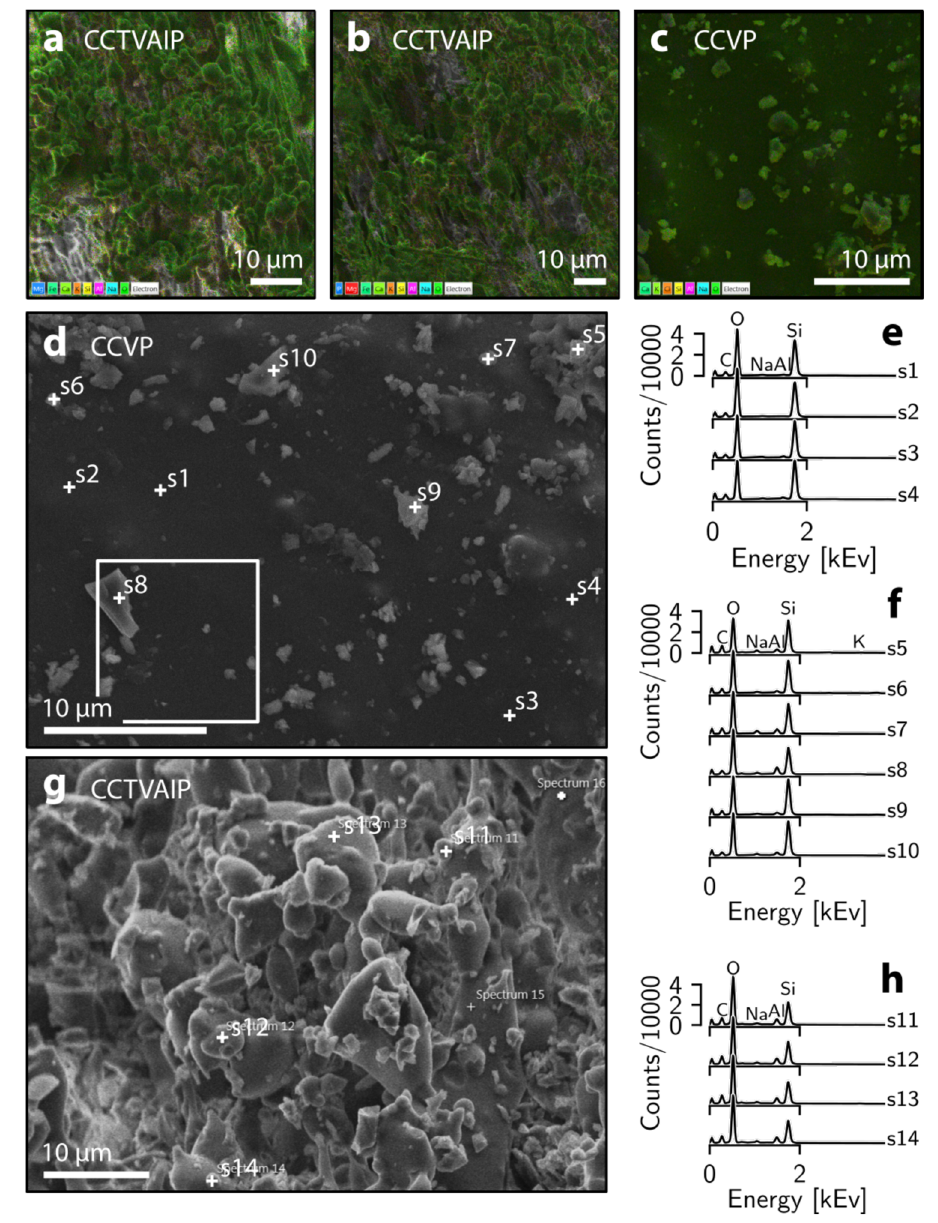
points s5 – s10 (discrete particles) in f . Peaks for C, O, Na, Al, Si, and K are high- lighted. Note white box showing area of Fig. 2m. g As ( d ), for sample CCTVAIP. Spectra for points s11 – s14 are shown in h